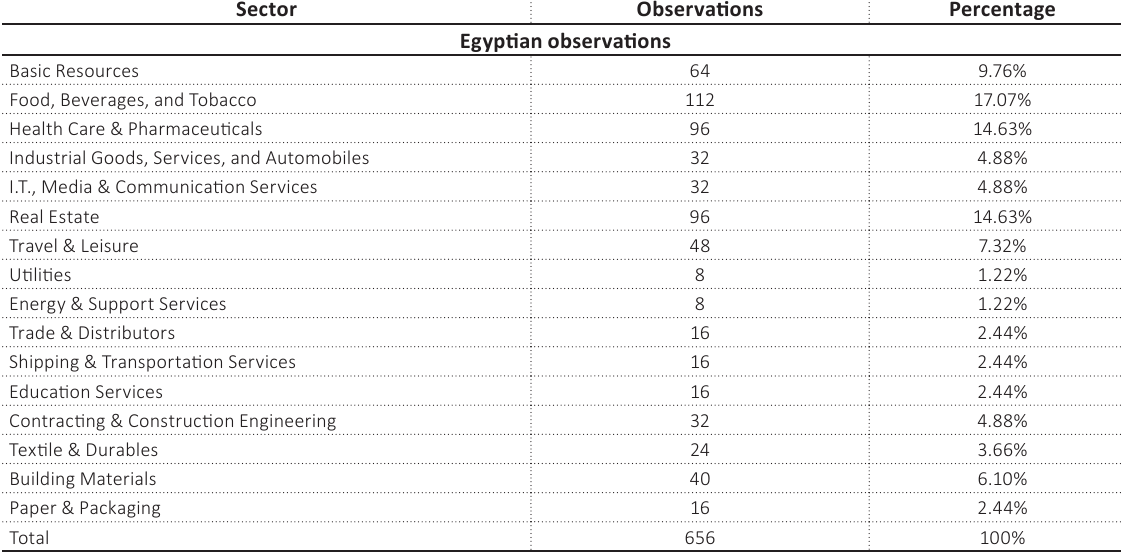
Table 1. Distribution of the